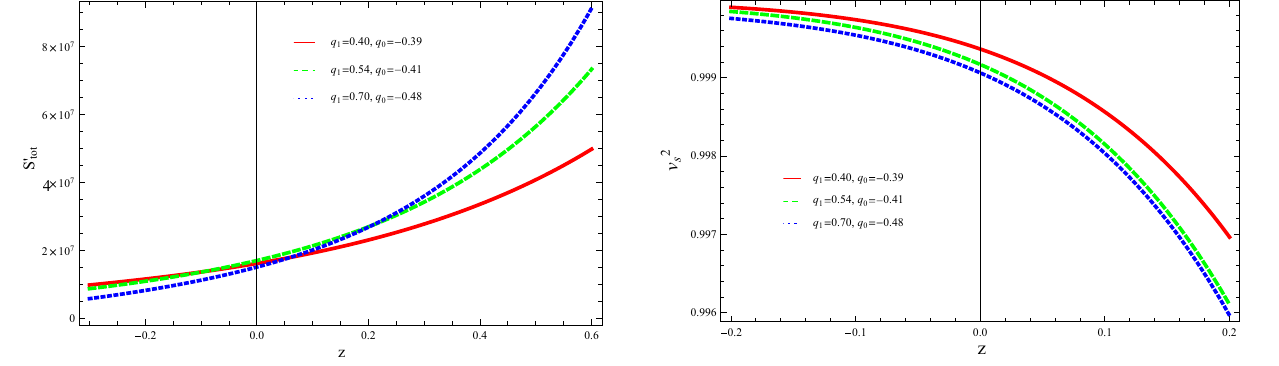
Fig. 10 Plot of v 2 s versus z at Hubble horizon with Bekenstein entropy